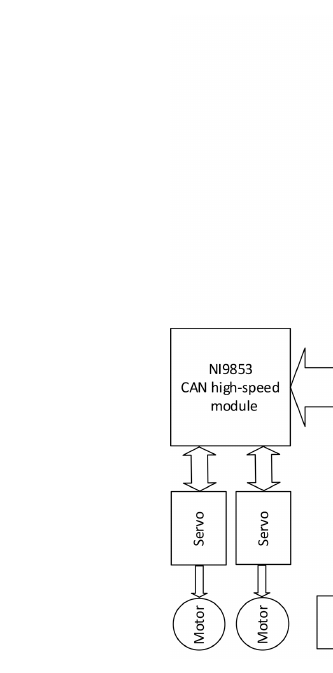
Figure 11. Measuring and control